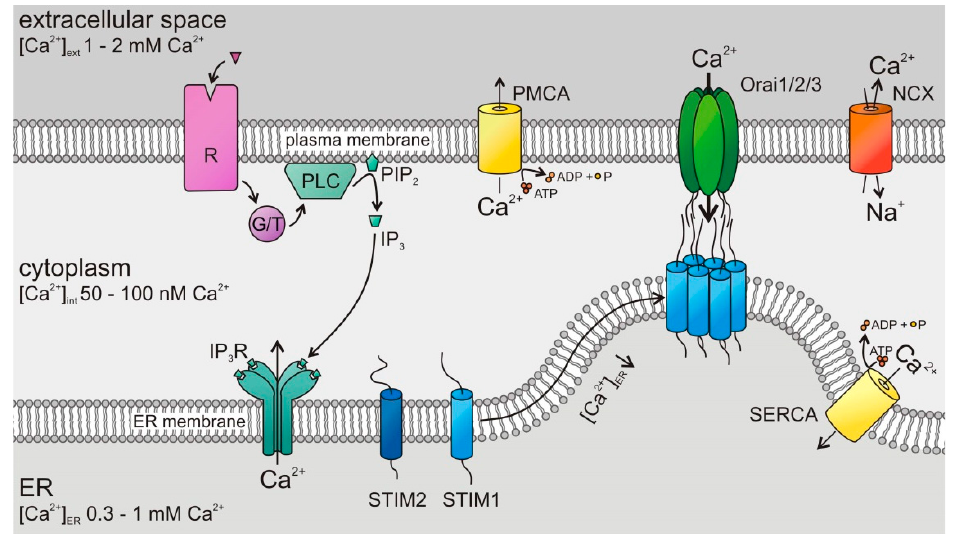
Figure 2. Store-operated Ca 2+ entry (SOCE) by stromal-interaction molecule (STIM)/Orai channels in cancer cells: Following the stimulation of G protein- or tyrosine kinase-coupled (G/T) receptors (R), phospholipase C (PLC) hydrolyses phosphatidylinositol 4,5-bisphosphate (PIP 2 ) to inositol trisphosphate (IP 3 ). The latter binds to its receptor, a Ca 2+ release channel in the endoplasmic reticulum (ER) membrane and opens it, which induces the Ca 2+ depletion of ER Ca 2+ stores. A drop of (Ca 2+ ) ER activates luminal Ca 2+ sensor proteins, the STIMs. Activated STIMs oligomerize and move to the plasma membrane where they bind and open Orai channels, leading to a Ca 2+ influx across the plasma membrane. Plasma membrane Ca 2+ ATPases (PMCAs), Na + –Ca 2+ exchangers (NCX), and sarco-/endoplasmic reticulum Ca 2+ ATPases (SERCAs) export Ca 2+ from the cytosol.